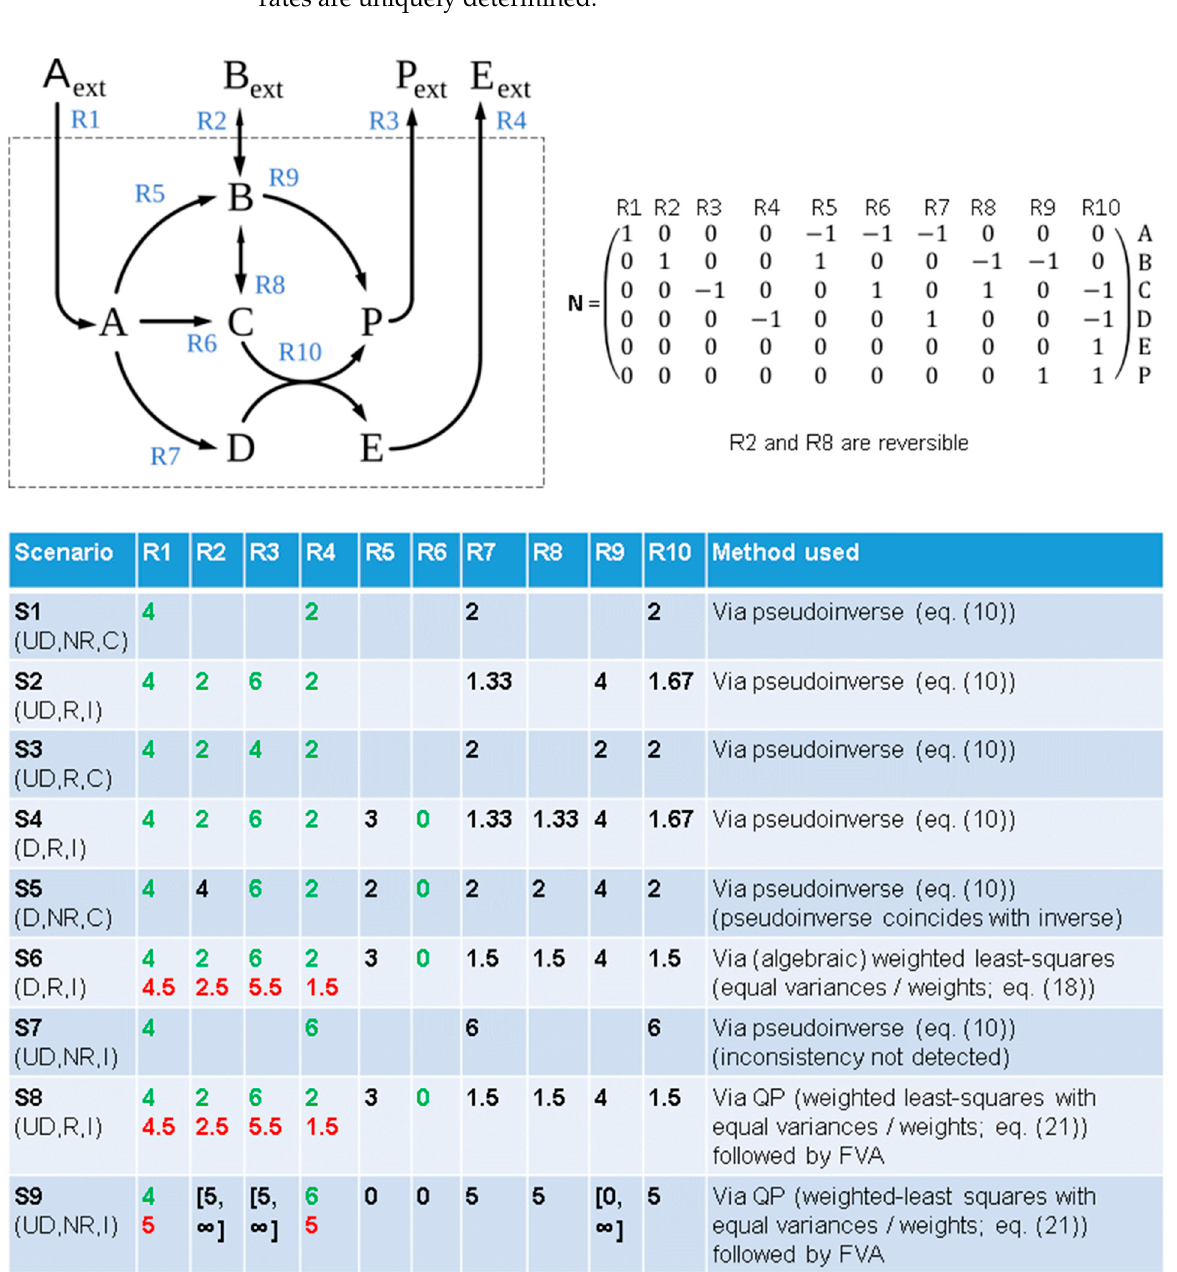
Figure 1. Example network with different MFA scenarios. Green values mark known (“measured”) reaction rates and red values indicate computed minimal corrections for the measured rates that make the scenario feasible. Black values correspond to reaction rates that can be uniquely determined from the given rates or, in case of scenario S9, they reflect identified ranges of feasible fluxes as determined by FVA. Each scenario is characterized by determinacy (D: determined; UD: underdetermined), redundancy (R: redundant; NR: non-redundant), and consistency/feasibility (C: consistent, I: inconsistent).